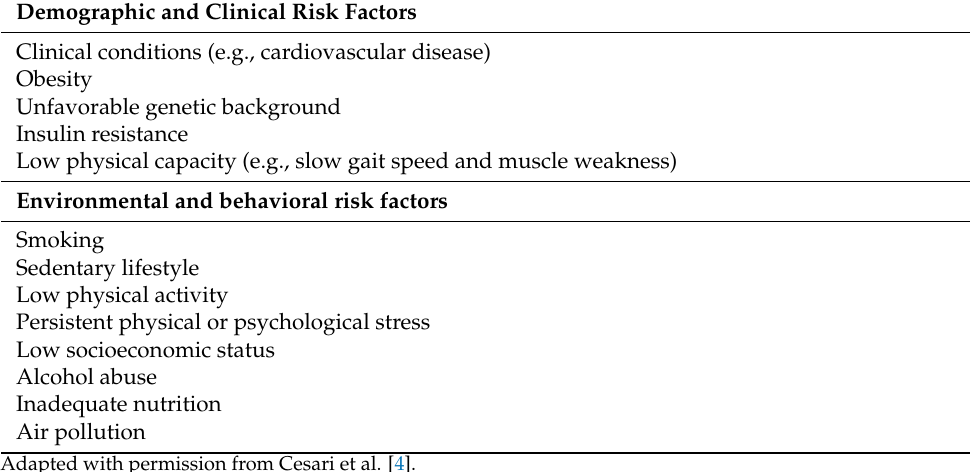
Table 2. Framework connecting biological mechanisms with the clinical phenotype of AACD. Underlying Cellular and Subcellular Networks